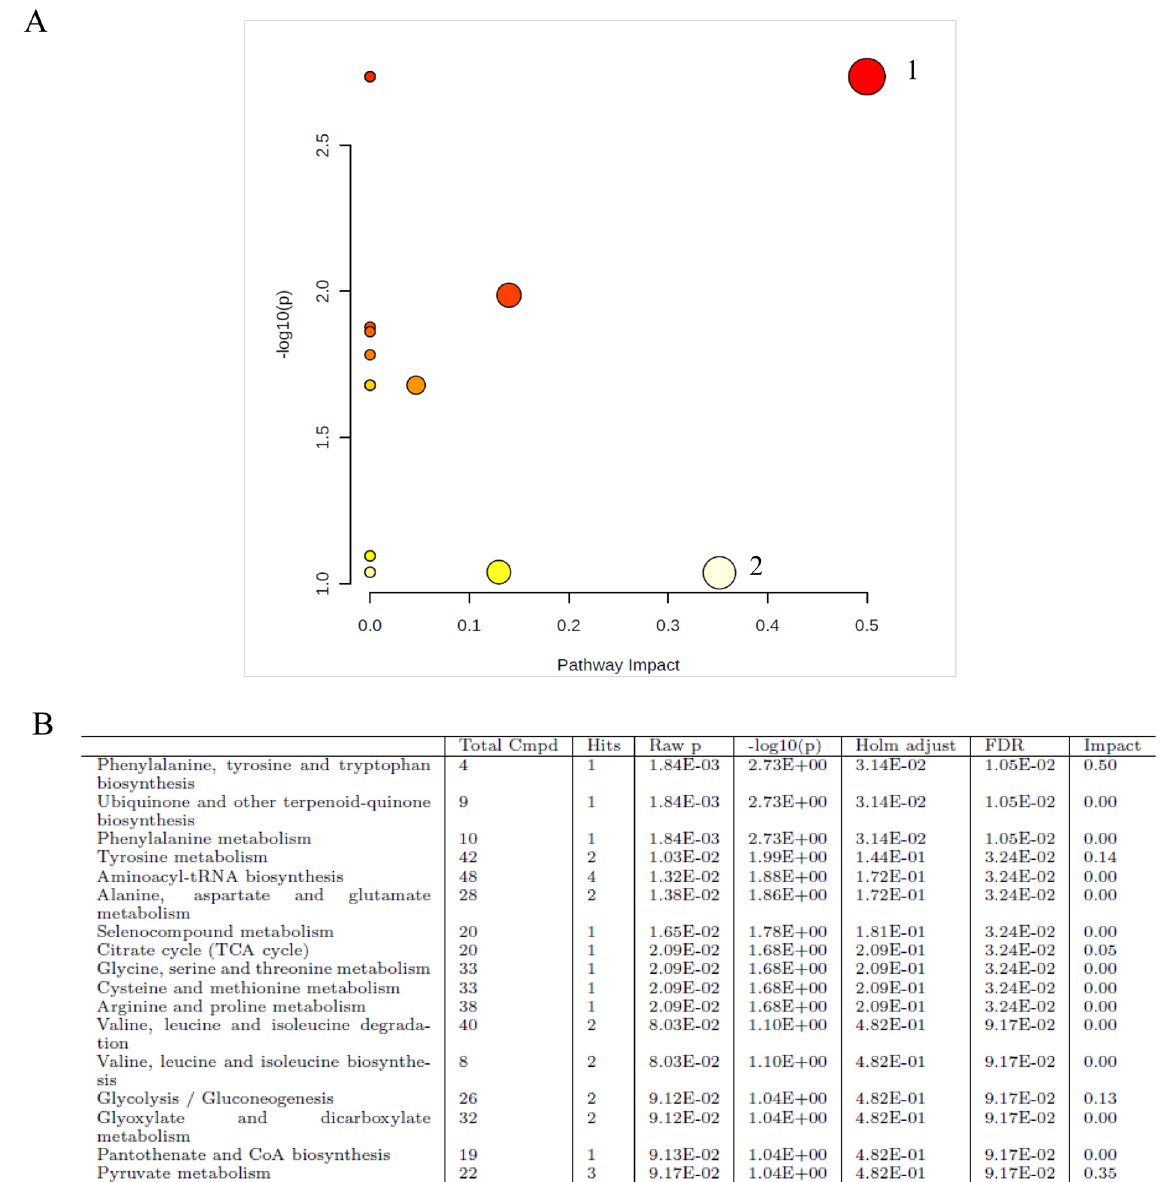
Figure 1. ( A ) Summary of pathways analysis using MetaboAnalyst (https:// www. metab oanal yst. ca): (1) phenylalanine, tyrosine and tryptophan biosynthesis; (2) pyruvate metabolism. ( B ) Detailed results of pathway analysis. Total Cmpd is the total number of compounds in the pathway; Hits is the actually matched number of compounds from the user uploaded data; Raw p is the original p value calculated from the enrichment analysis; Holm is the p value adjusted by Holm-Bonferroni method; FDR is the p value adjusted using False Discovery Rate; Impact is the pathway impact value calculated from pathway topology analysis (EPIC Florence, low- vs high-MBD BC case–case